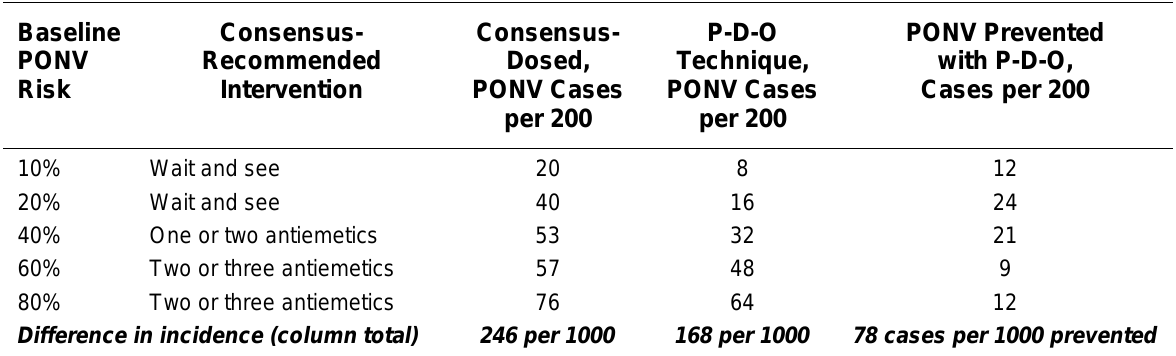
Side-by-Side Estimated Incidences of PONV when the Consensus Guidelines are Followed vs. the Proposed Perphenazine-Dexamethasone-Ondansetron